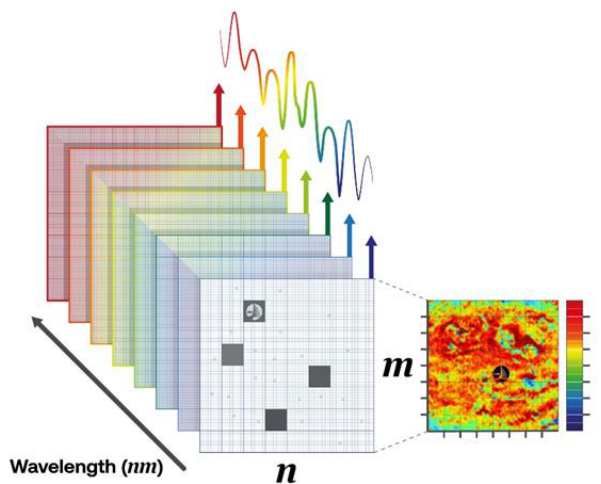
Figure 3. Graphic representation of a hyperspectral cube acquired with the industrial hyperspectral system VISUM ® HSI TM . Each hyperplane (slide) of the cube corresponds to a spectral channel or wavelength band.